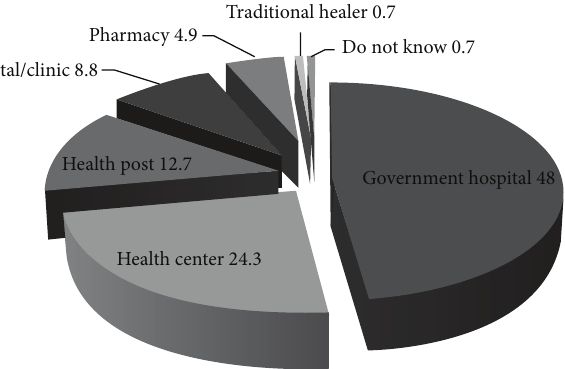
Traditional healer 0.7 Do not know 0.7